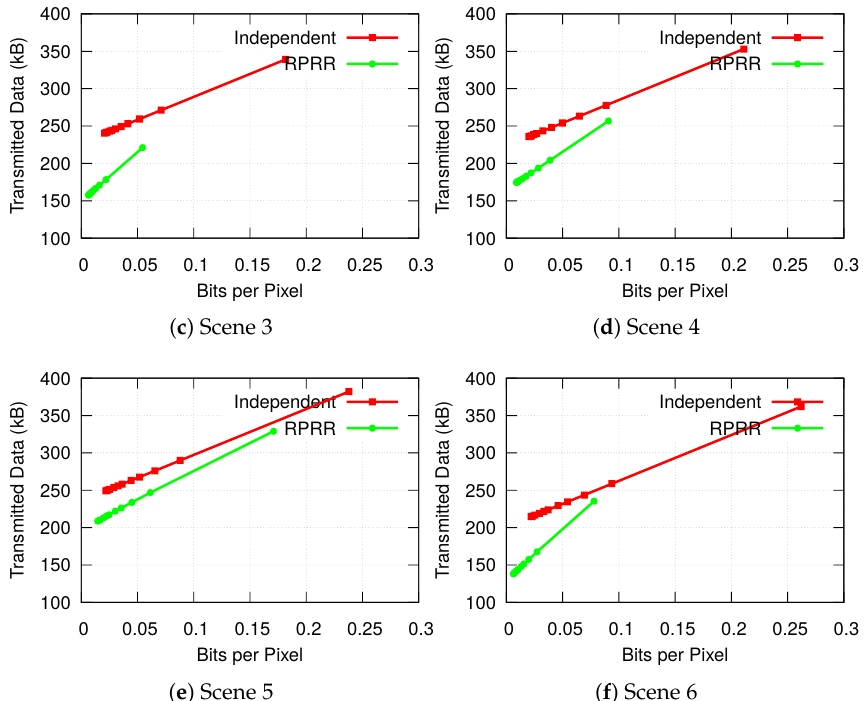
Figure 14. Comparisons of the transmitted data for color images at various compression levels by using the RPRR framework against transmitting them